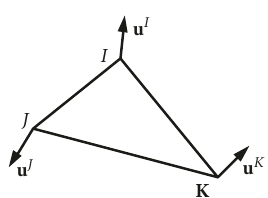
Figure 1: A triangular